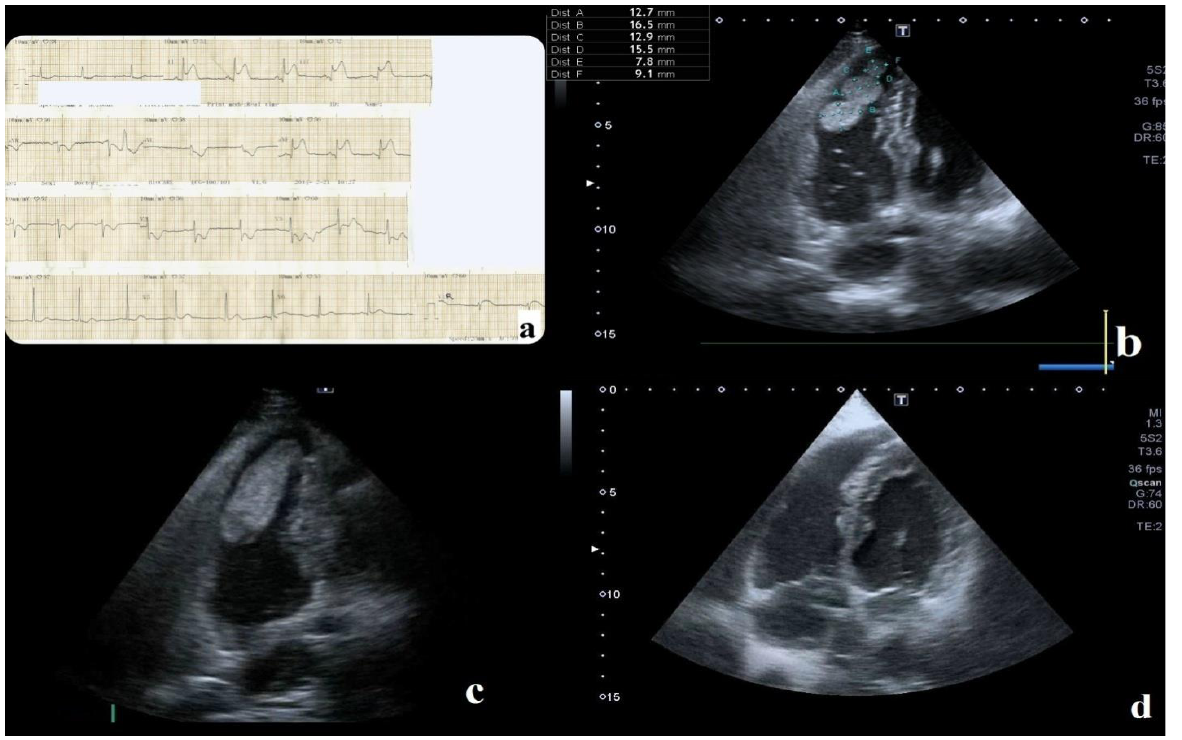
Figure 1. Electrocardiogram and sequential 2D Echocardiograms of the